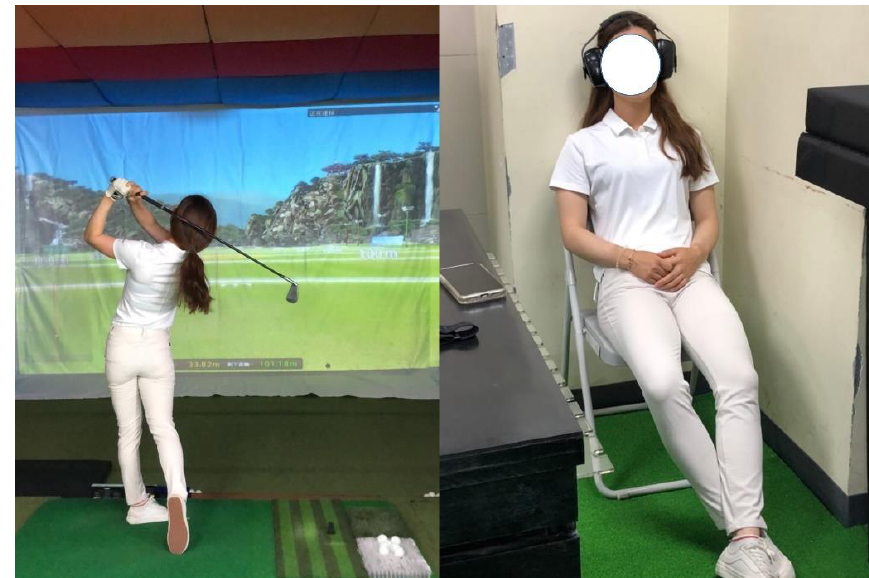
Figure 1. Flow diagram of the study.